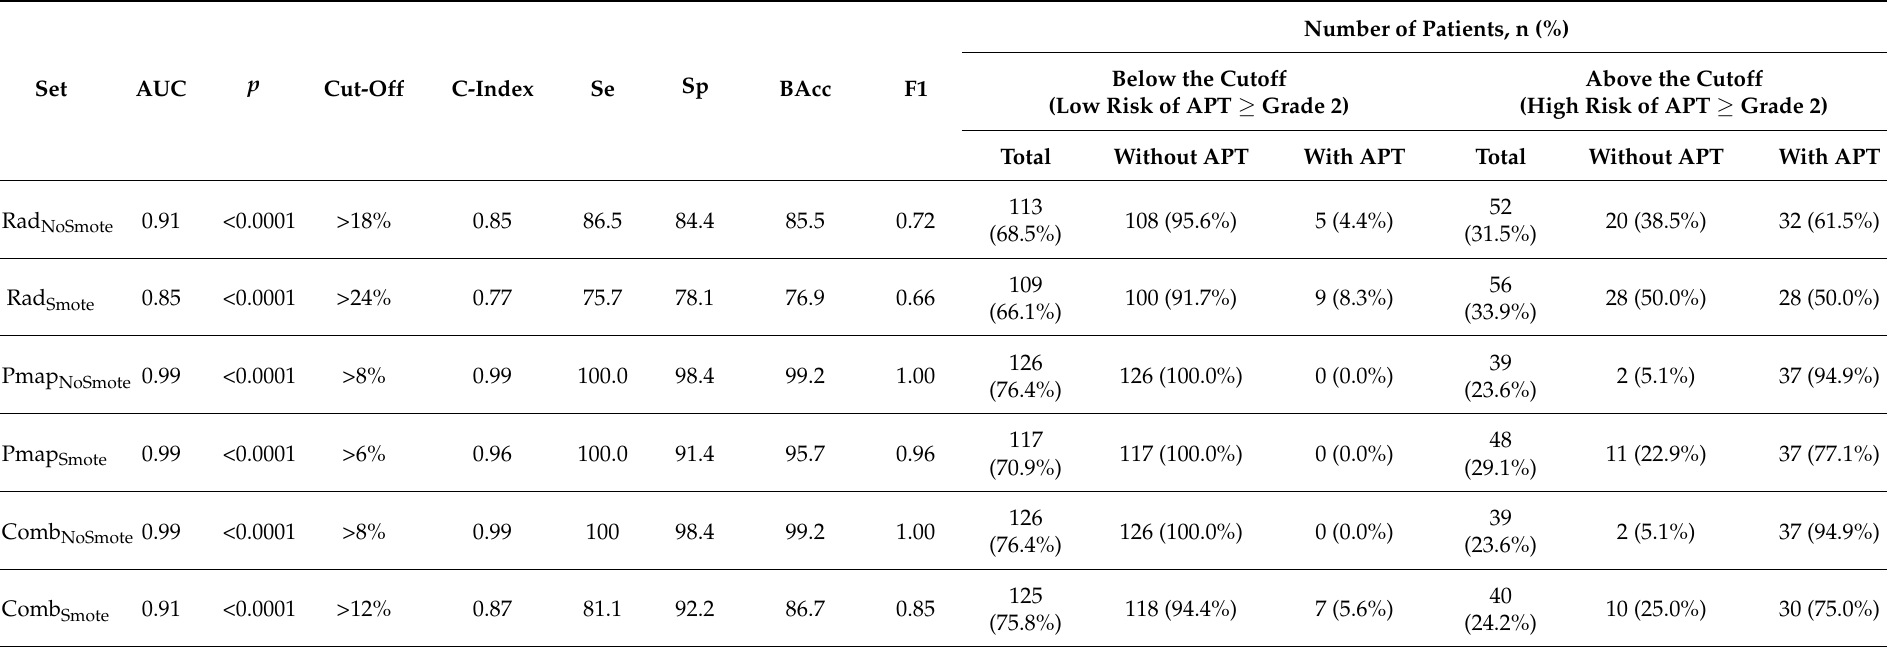
Table 1. Analysis of each model’s discrimination between patients with or without APT ≥ grade 2 in the training